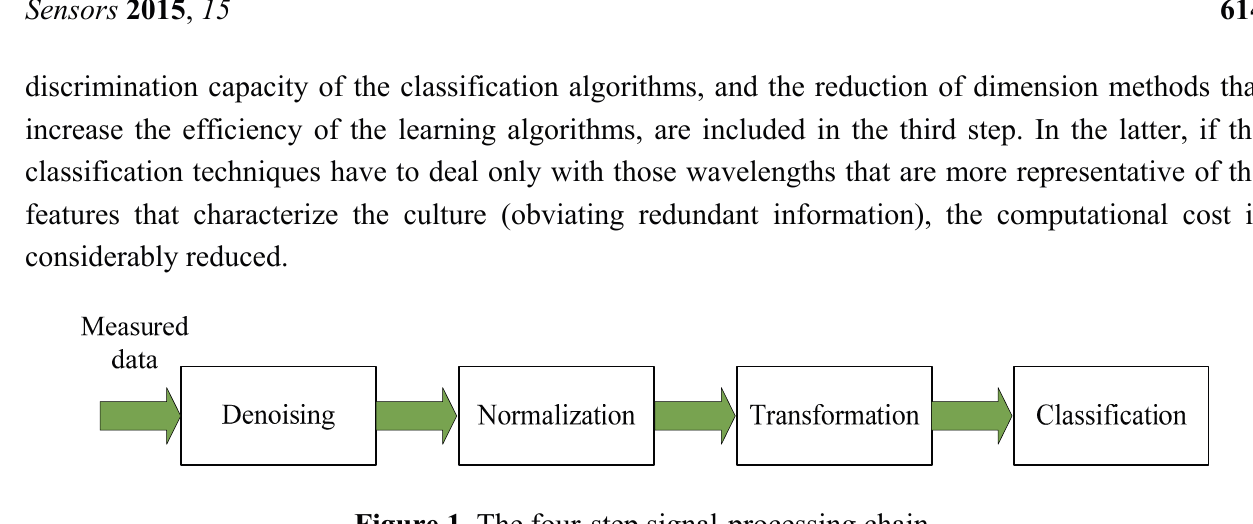
Figure 1. The four-step signal-processing chain.